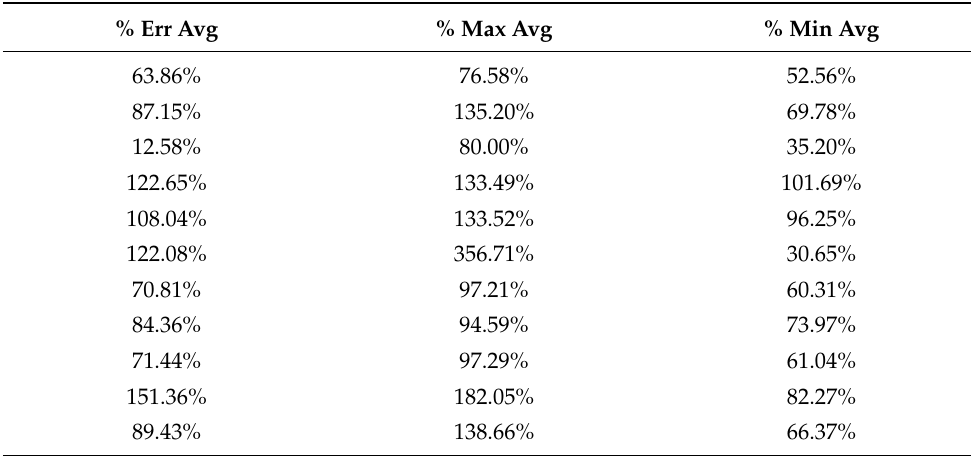
Table A212. Set 3, trials 31–40 data (average actual PR values).